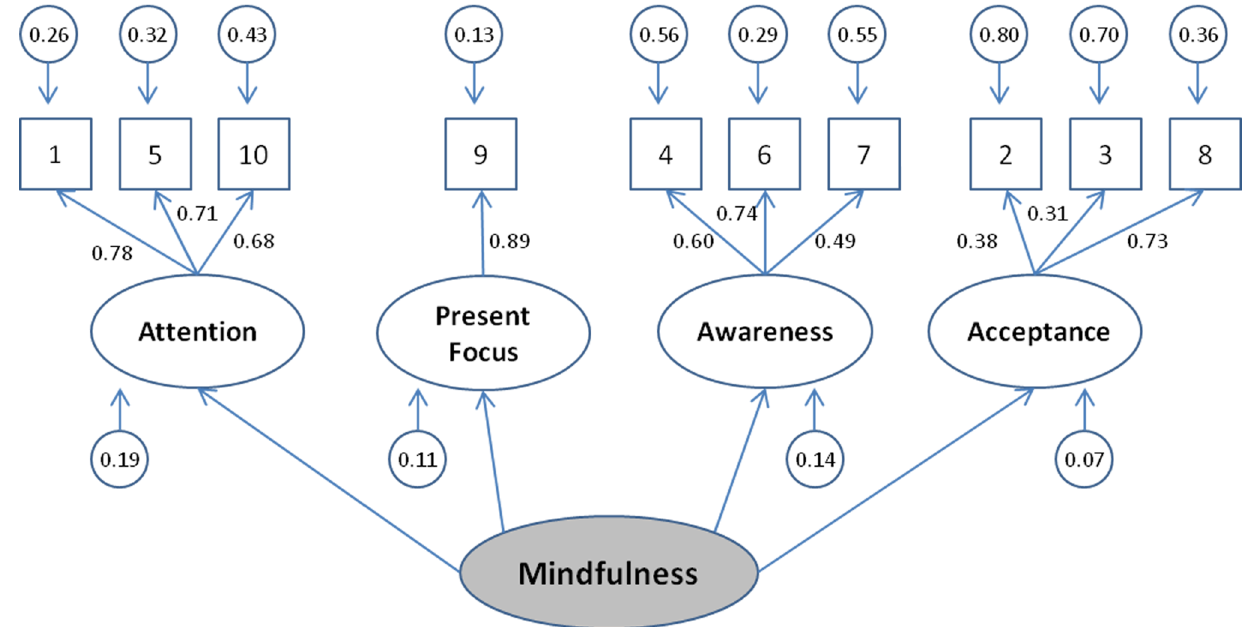
Figure 1. Standardized parameter estimates of the second order CFA for the Turkish version of 10 item Cognitive and Affective Mindfulness